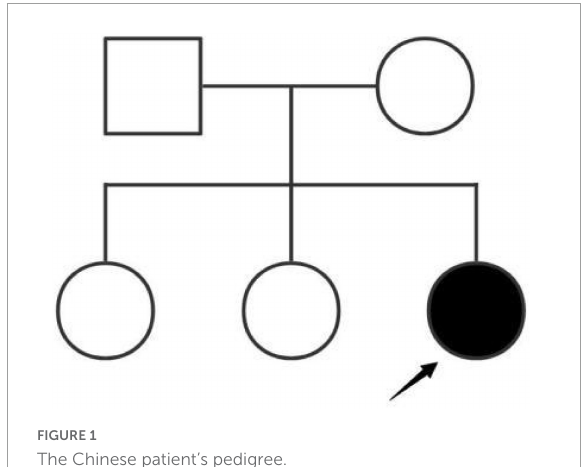
FIGURE1 The Chinese patient’s